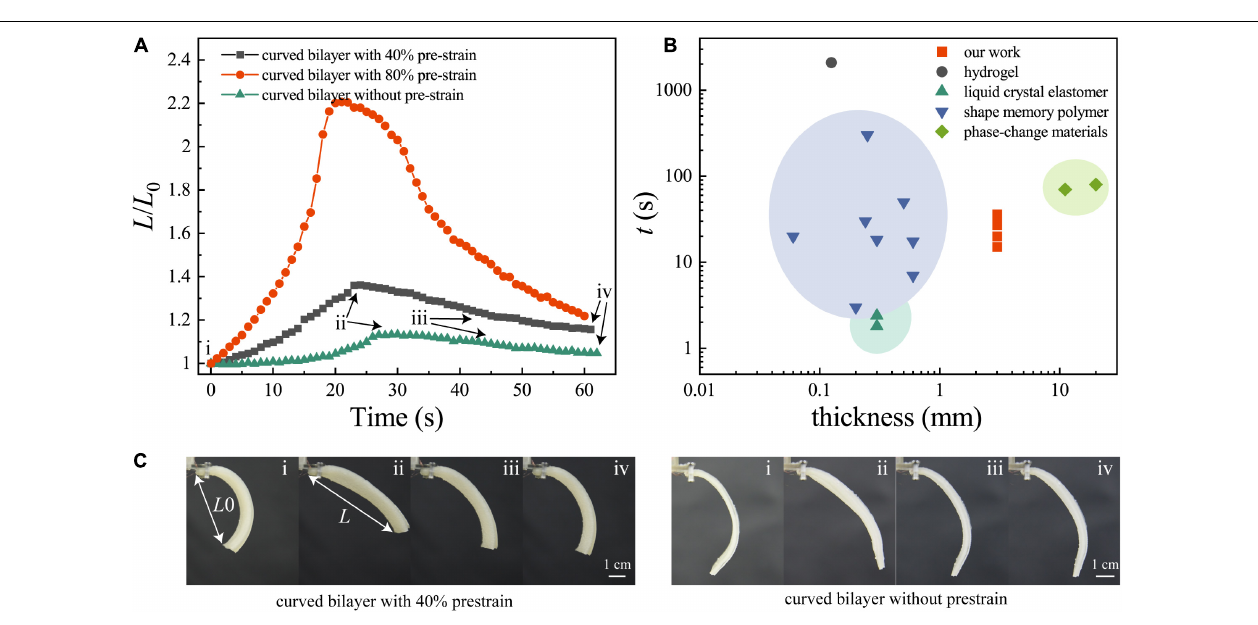
FIGURE 6 | Deformation of the wide bilayer. (A) The variation in the relative length of the curved bilayer as a function of time. (B) The comparison of deformation time between our work and other thermal responsive structures with different thicknesses in the literature. (C) Deformation sequence for bilayer with 40 % pre-strain (left) and without pre-strain